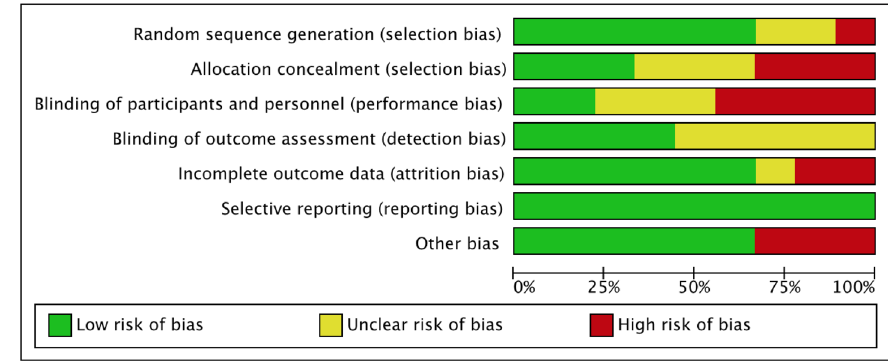
Figure 2. Overall bias risk chart of all included